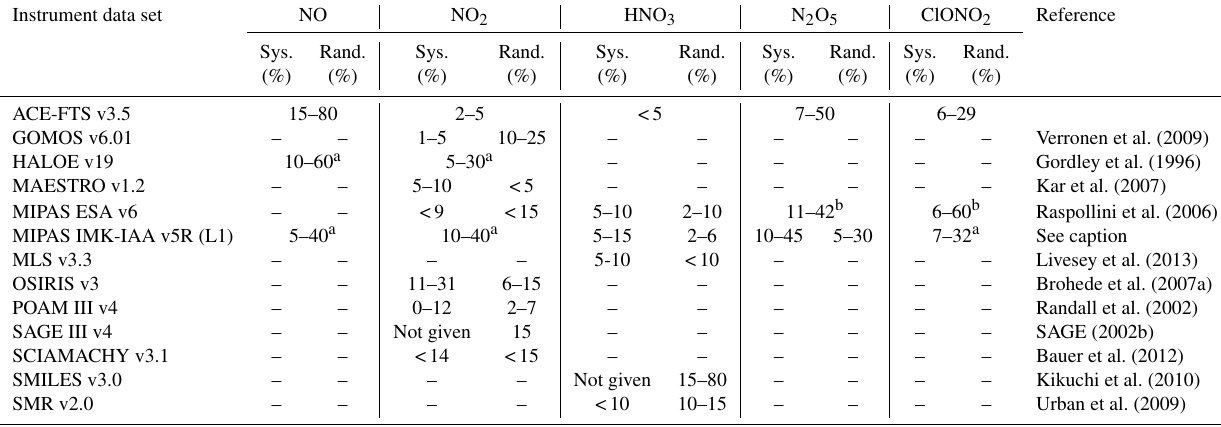
SMILES v3.0 SMR v2.0 Table 2. Reported retrieval uncertainties for the data sets used in this study. The listed ACE-FTS values represent mean statistical fitting errors (Boone et al., 2005). The values given are in the altitude range of 20–60km for NO, 20–40km for NO 2 , 15–30km for HNO 3 , 20–40km for N 2 O 5 , and 17–38km for ClONO 2 . The MIPAS IMK-IAA uncertainties were obtained from the respective validation studies discussed in Sect. 2.2.2. Note that these are the uncertainties reported as “systematic” and “random” uncertainties and are not all necessarily at the same confidence